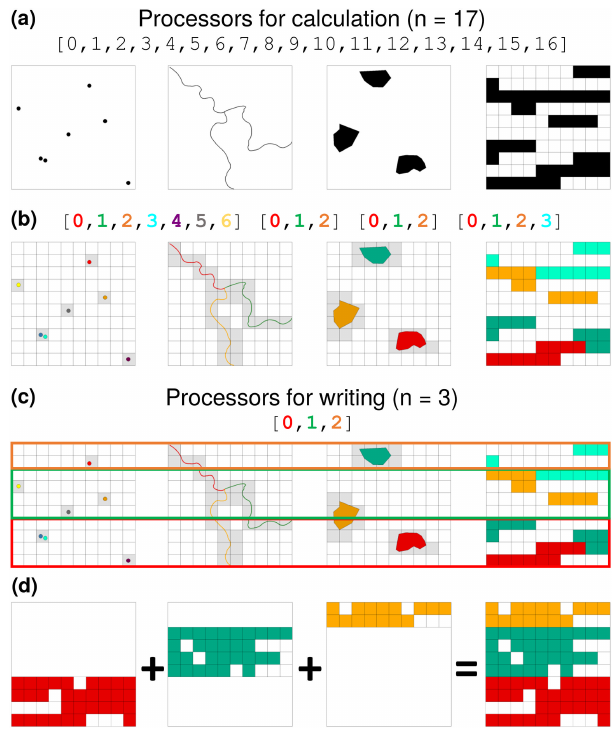
Figure 8. Illustrative example of how HERMESv3_BU parallelizes the calculation and writing processes and distributes the computa- tional resources. (a) A total of 17 processors are selected to esti- mate emissions from point sources, road transport, aviation and an area source sector (e.g. residential combustion). (b) The calculation processors are distributed as follows: seven for the point sources (one processor per facility), three for road transport (one proces- sor per road link), three for aviation (one processor per polygon) and four for residential combustion (one processor per subgroup of cells equally balanced, i.e. 10 cells per subgroup). Each processor estimates the emissions of the corresponding partitioned element and maps them onto the intersected grid cells (highlighted in grey). (c) During the writing process, HERMESv3_BU decompose the destination working domain into three horizontal sections (equiva- lent to the number of writing processors selected), maintaining each row as indivisible. (d) For each horizontal section, the model gath- ers the estimated gridded emissions of all the sources involved in that section and then computes the total sum per grid cell. Once this operation is finished, the resulting emissions are dumped into the corresponding section of the output